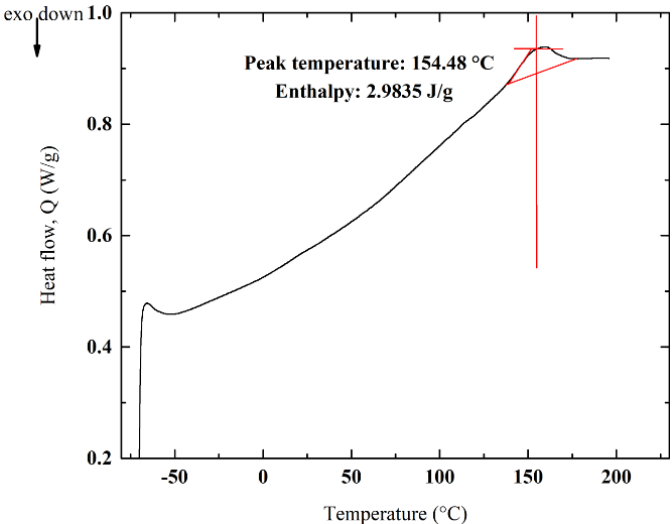
Figure 10. DSC curves for PECH-H in N 2 .